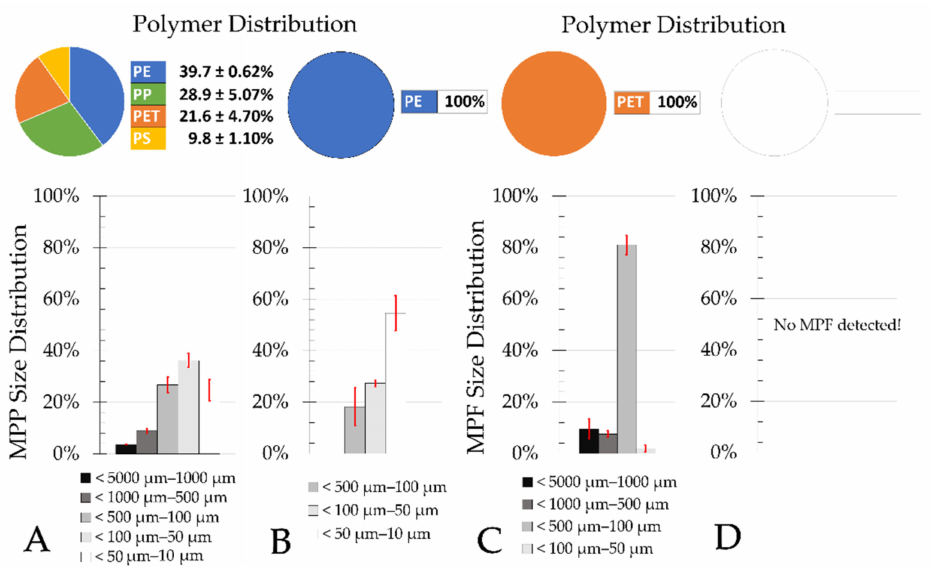
Figure 5. Average MPP polymer- and size distribution of the final clarifier effluent ( A ) and sand filter effluent ( B ) and average MPF polymer- and size distribution of the final clarifier effluent ( C ) and sand filter effluent ( D ) of the of the Mannheim